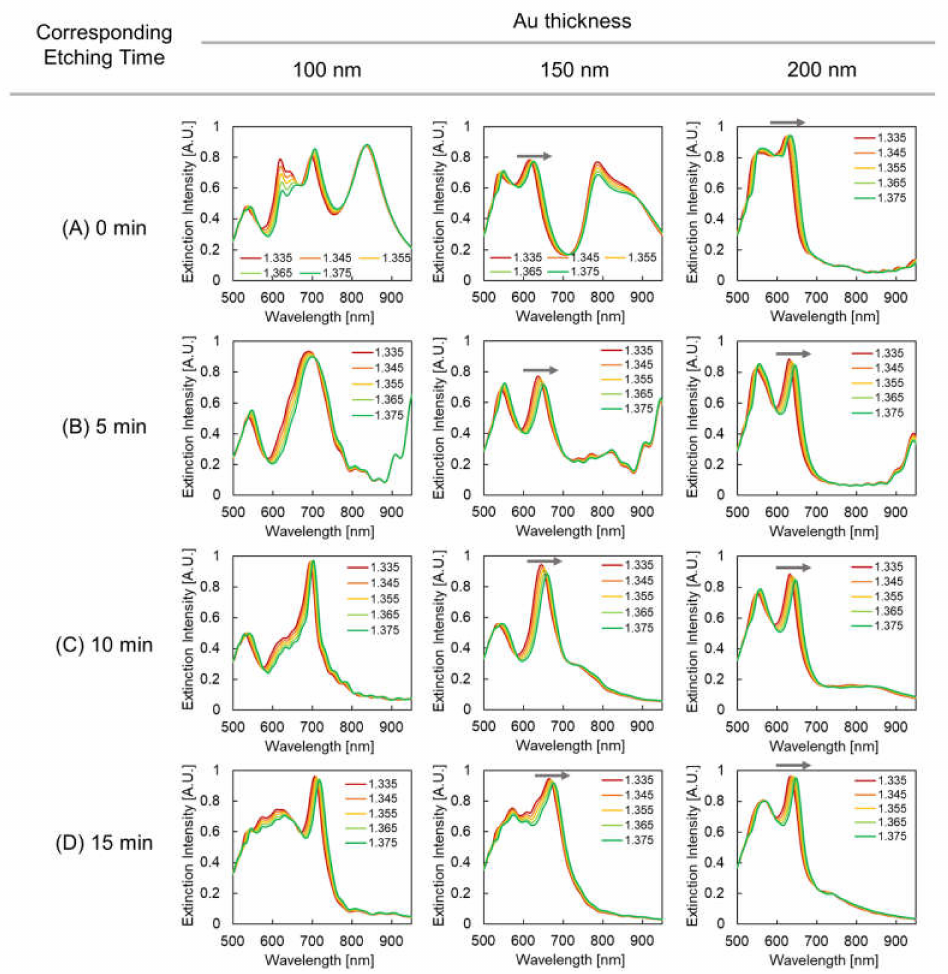
Figure 11. Simulated extinction spectra of plasmonic devices dependent on surrounding refractive index. Columns indicate Au thickness, and rows indicate corresponding etching times: ( A ) 0 min, ( B ) 5 min, ( C ) 10 min, and ( D ) 15 min, and the chart series in the graphs indicates the surrounding refractive index. The gray arrows in the figures indicate the spectral shift (peak shift) evaluated in this